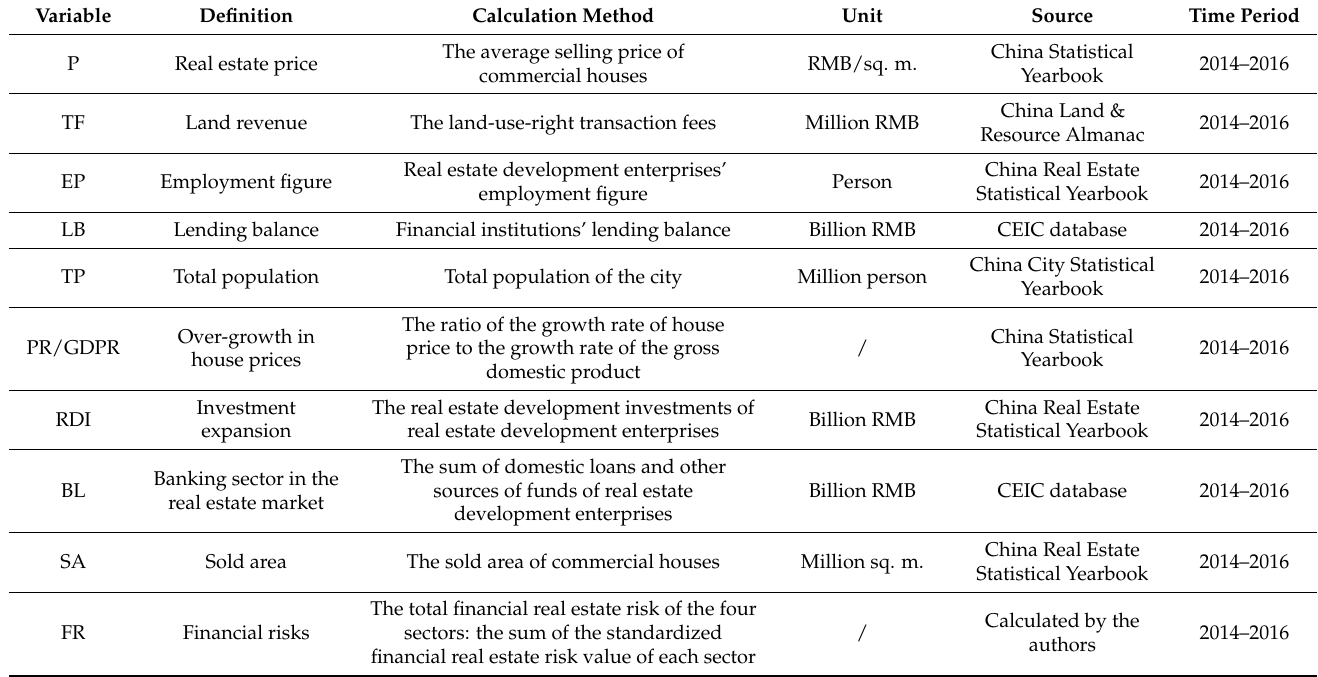
Table 1. The definition of variables.